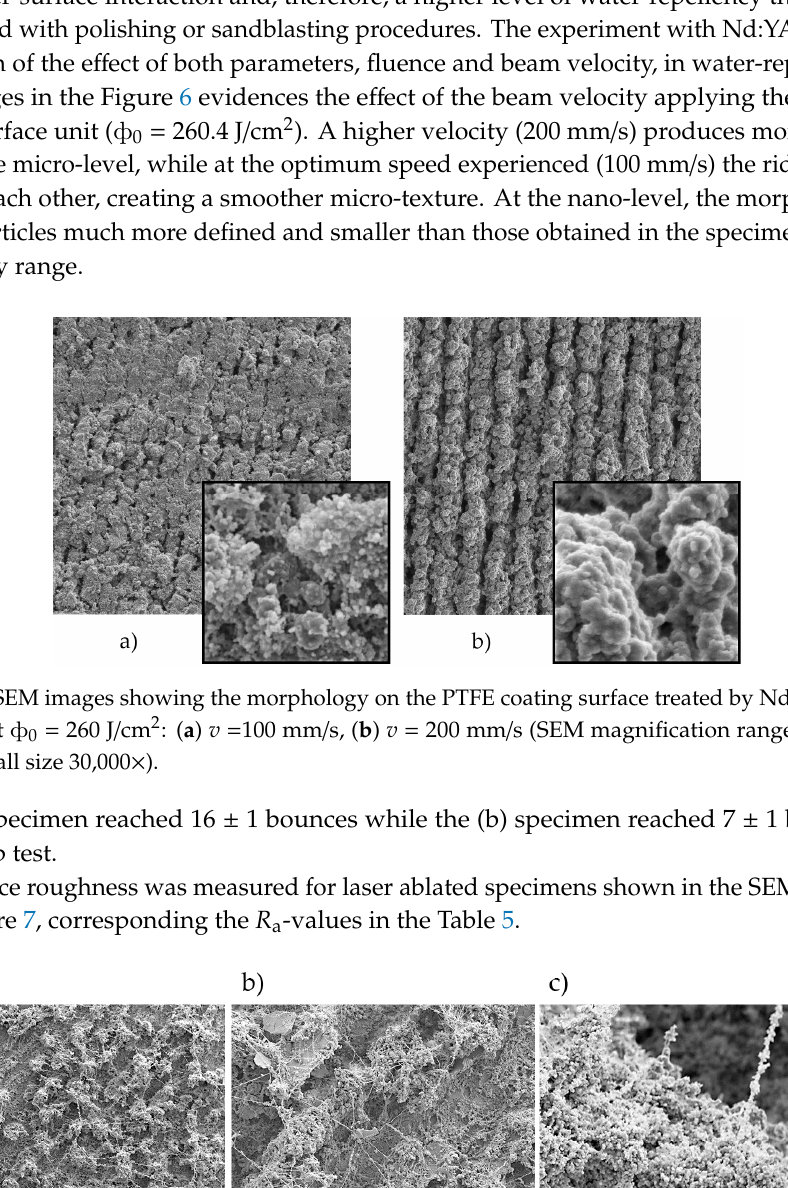
Figure 7. SEM images showing the morphology on the PTFE coating surface treated by Nd:YAG laser ablation at ф 0 = 290 J/cm 2 , v = 100 mm/s at magnification ranges: ( a ) 150×; ( b ) 500×; ( c ) 10,000×; ( d ) 15,000×.